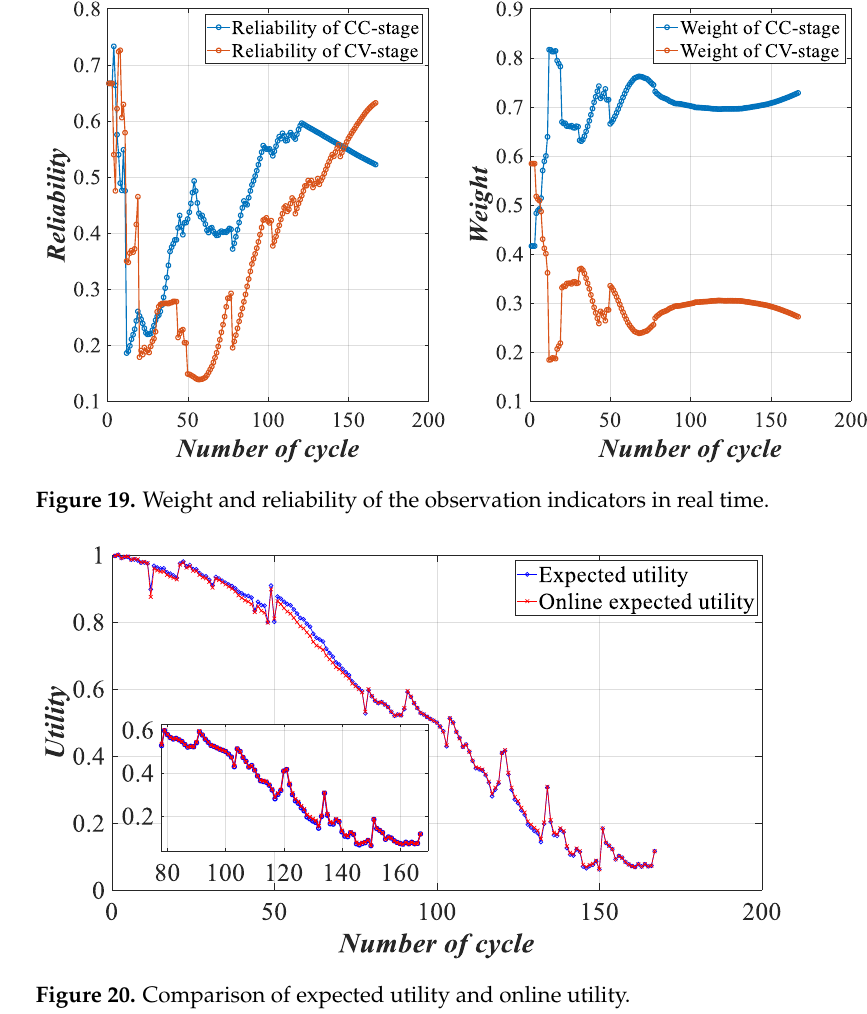
Figure 20. Comparison of expected utility and online utility.